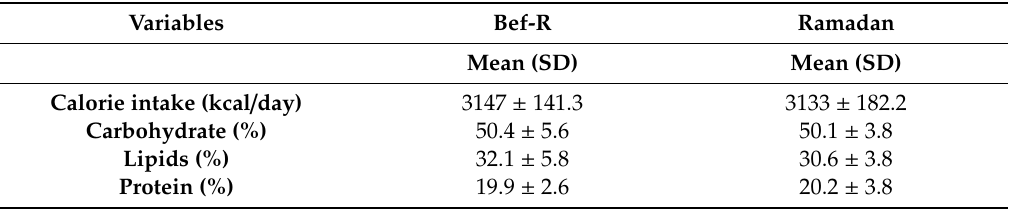
Table 2. Averages ( ± SD) of daily calorie intake and percentages of carbohydrates, fats and proteins recorded before and during the month of